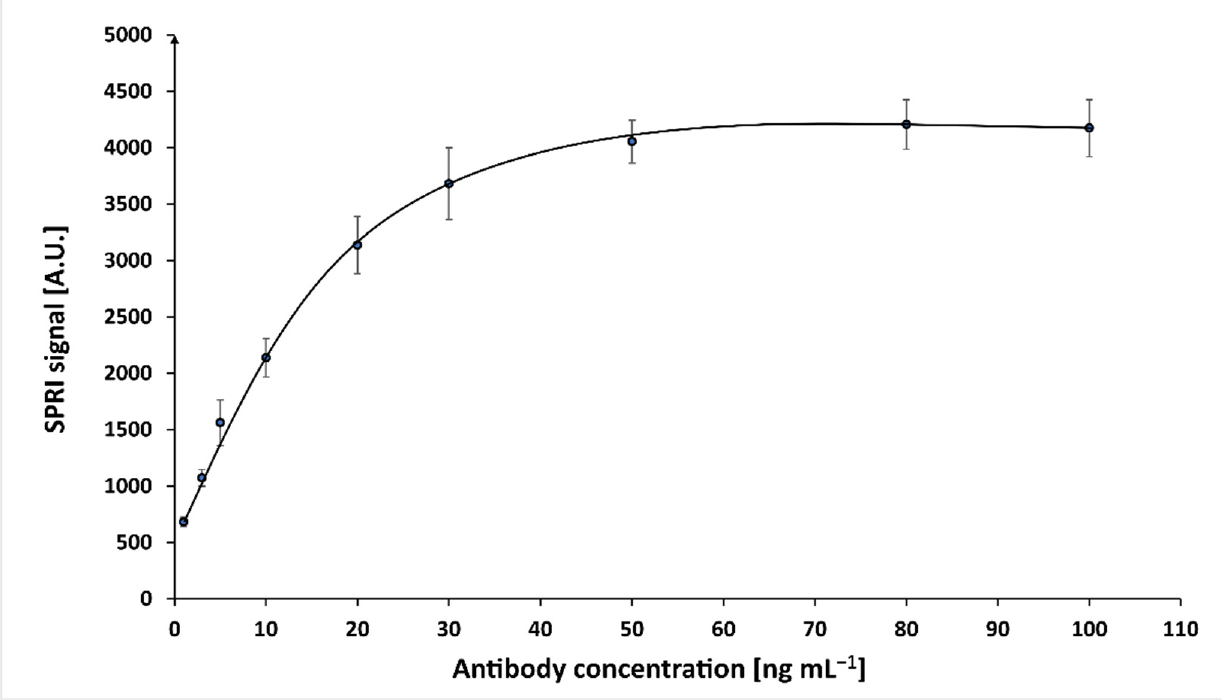
Figure A2. Dependence of the analytical signal on the concentration of mouse monoclonal antibody against cortisol (cortisol concentration 10 ng mL − 1 , pH = 7.4).